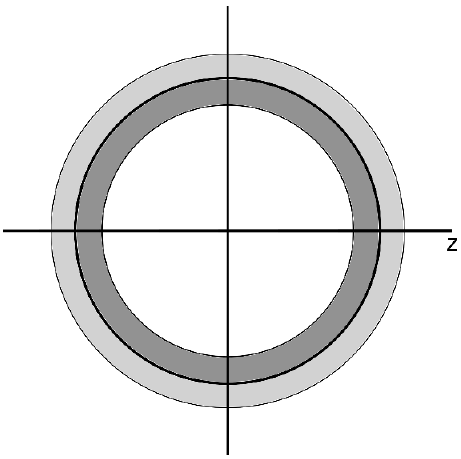
Figure 2 . In order to ensure dominance of the identity Virasoro block the states are assumed to be generated by heavy primary operators inserted into the dark shaded region A . As a result all hermitian adjoint operators are located in the light shaded region. The dark shaded region manifest in (2.1) as the integration region over which the operators are (potentially)